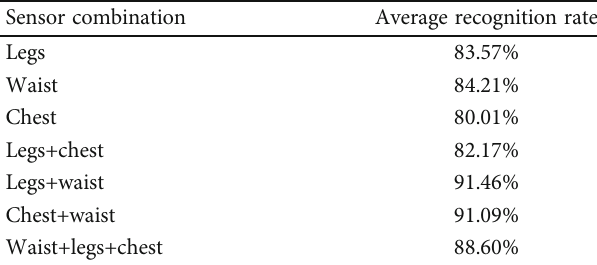
Table 1: Performance comparison of multisensor position